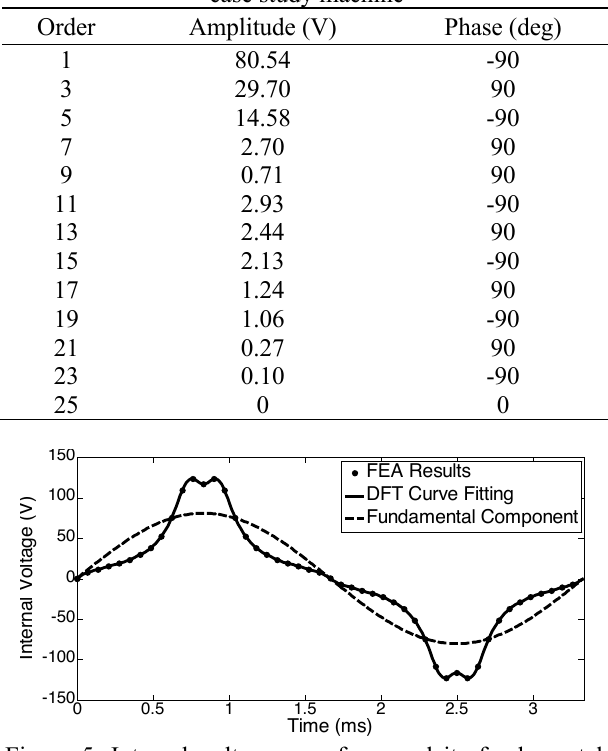
Figure 5: Internal voltage waveform and its fundamental component for phase